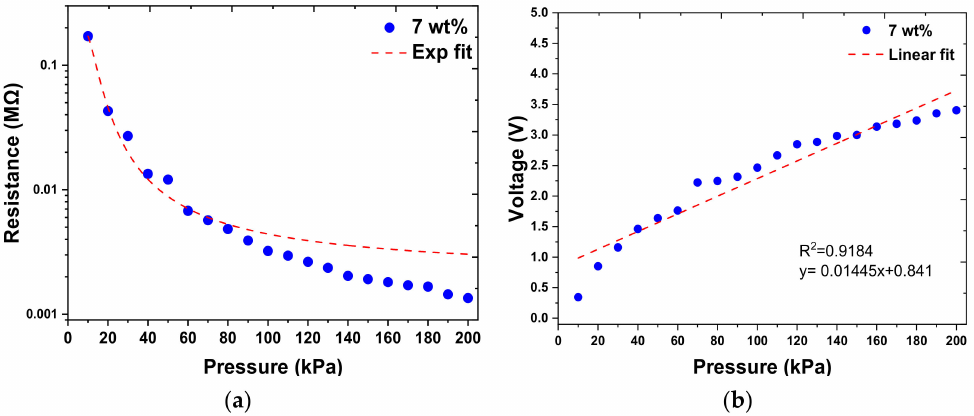
Figure 15. Pressure vs. resistance/voltage output for the sensors made with 7 wt.% MWCNT doping ratio. ( a ) Pressure vs. resistance response and ( b ) pressure vs. voltage response.